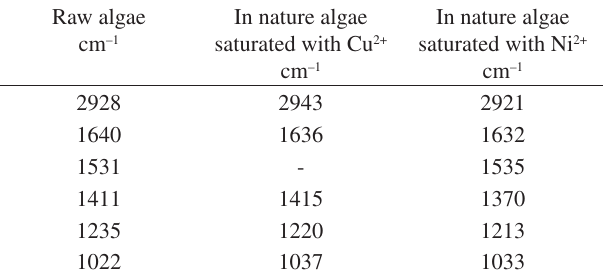
Table 4. Changes promoted by Cu 2+ and Ni 2+ loading in raw algae. Raw